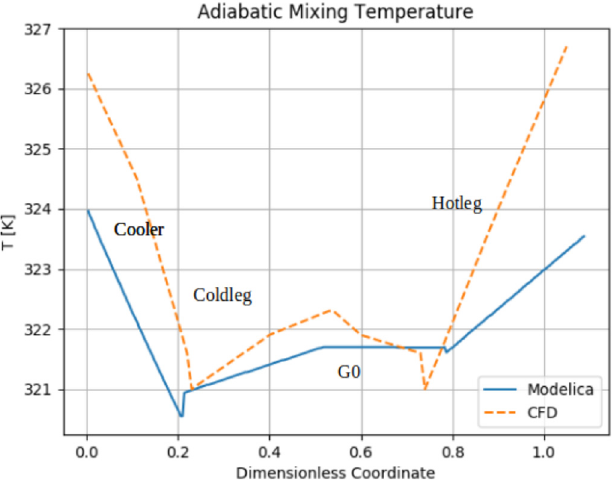
Fig. 14. Adiabatic mixing temperature for stabilized